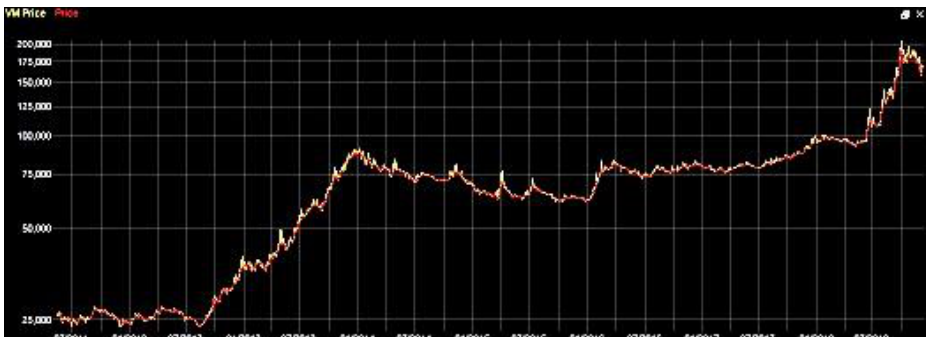
Fig. 6. Time series plot of TEPIX 80% of the total population; the red curve is the historical “TEPIX” quotes; the yellow curve is the series estimated by ‘Residual